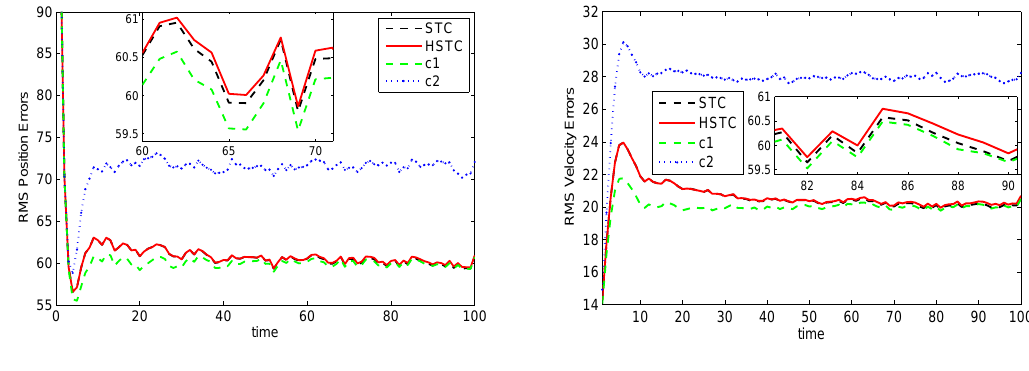
Figure 1. RMS error of position and